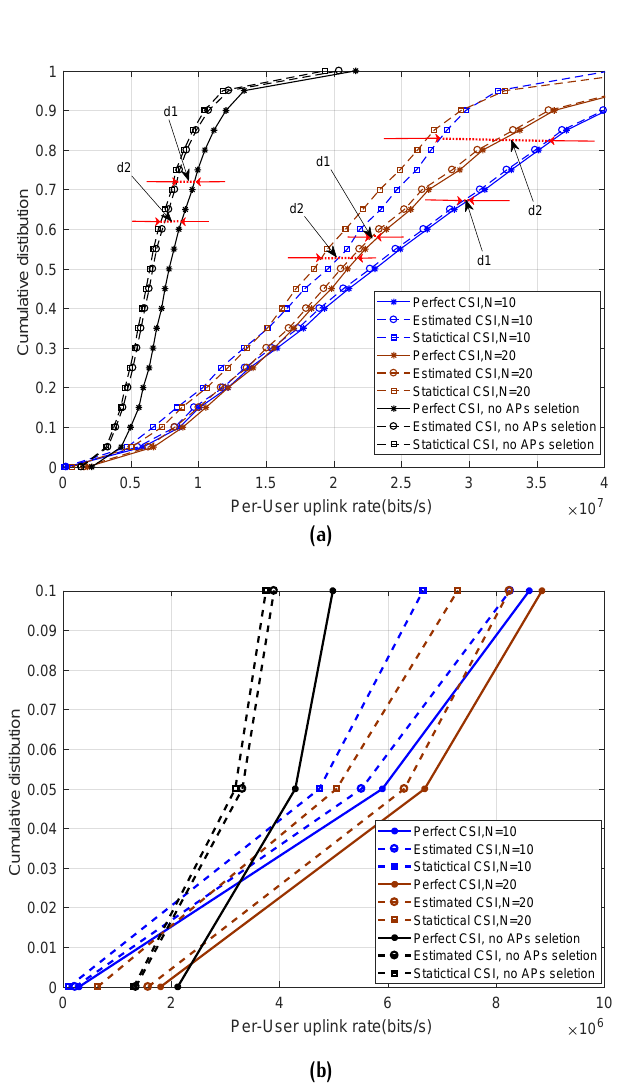
Figure 3. The cumulative distribution of the per-user uplink net throughput for the case of M = 200 and K = 20 . (3b) is the